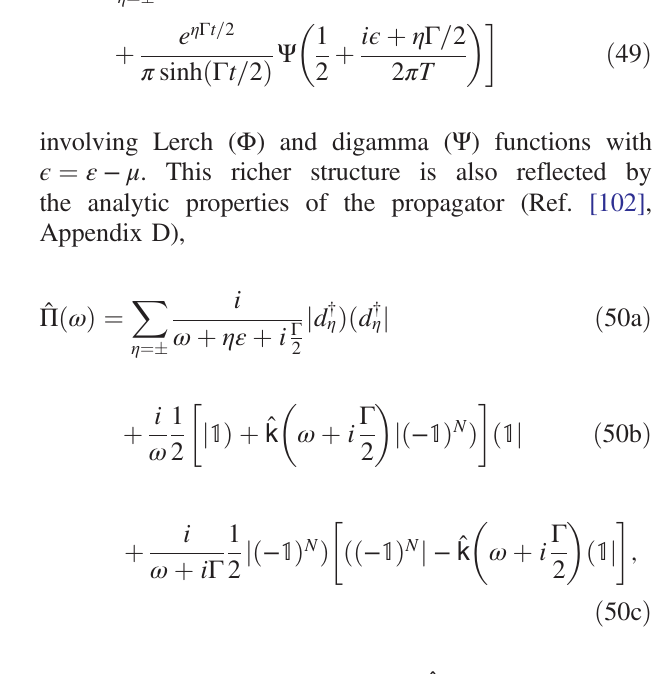
Table II, include two infinite series for T > 0 , which merge into branch cuts as T → 0 .